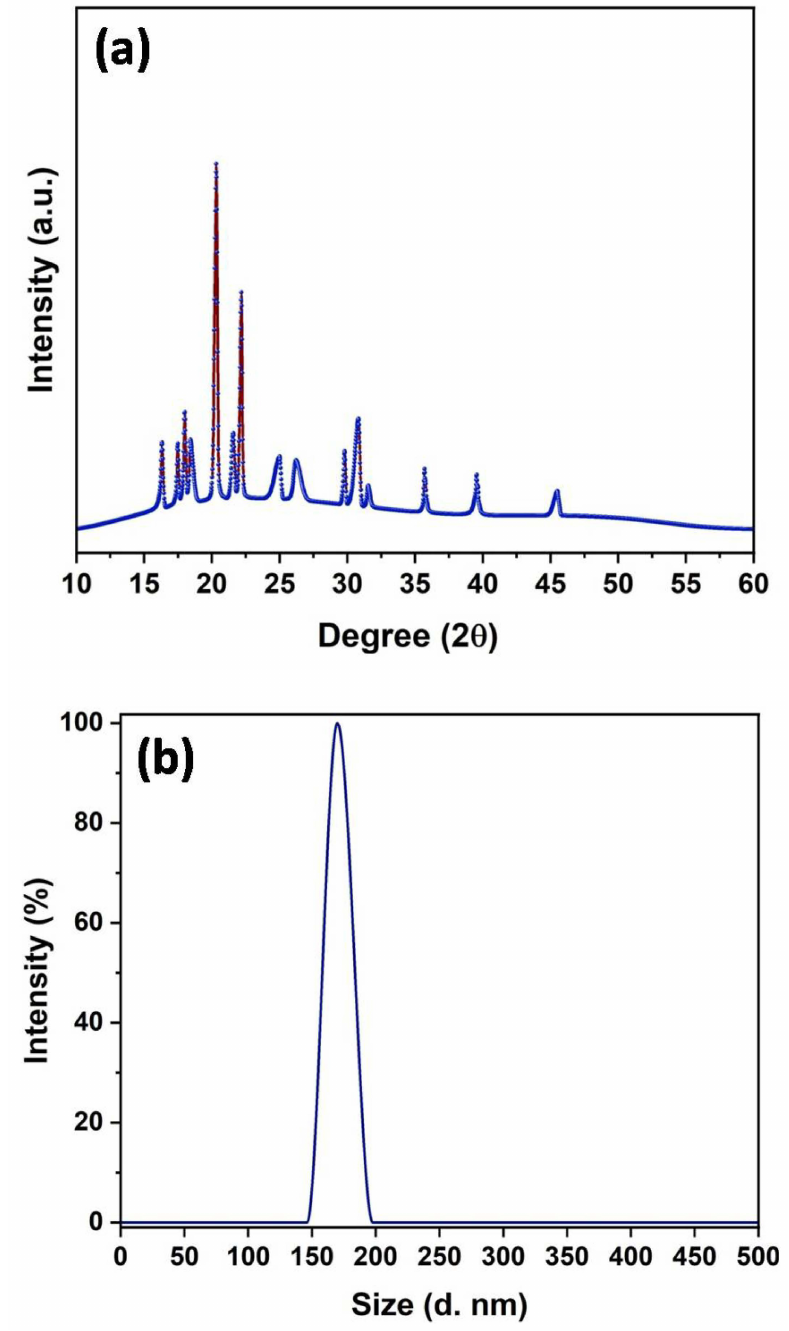
Figure 3. ( a ) XRD pattern, and ( b ) DLS spectra of synthesized